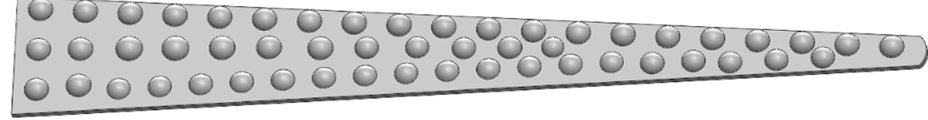
Figure 3. Dimpled section of a turbine blade.